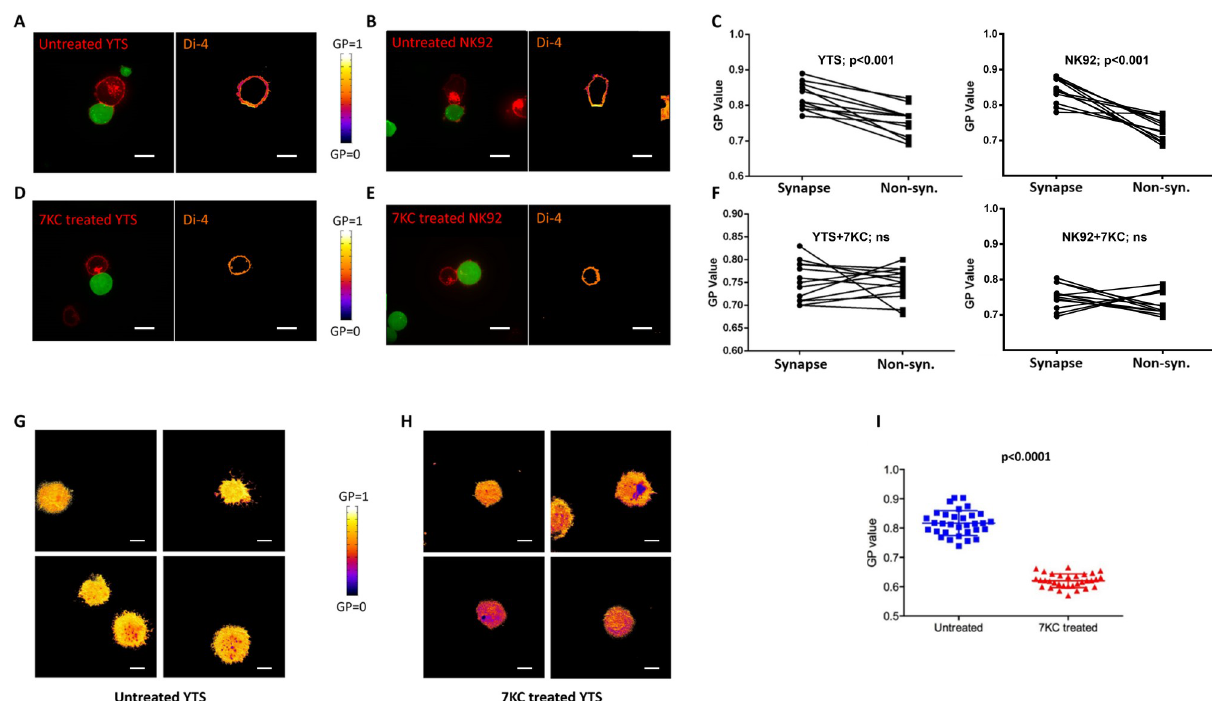
Fig 1. NK cells assemble presynaptic membranes with high lipid order during target cell engagement. The lipid packing of NK cell membranes in fluorescent packing sensor labeled YTS (A, D) and NK92 (B, E) conjugated with calcein green–loaded 721 or K562 target cells, respectively, was measured using live cell confocal microscopy (left image). 7KC-treated and untreated NK cells were overlaid with a pseudocolor scale (A, B, D, E–right image) to demonstrate differences in packing. Membrane lipid density was quantified as a GP value, which was measured in distinct conjugates ( n = 12 for untreated YTS, n = 14 for 7KC-treated YTS, n = 12 for untreated NK92, n = 12 for 7KC-treated NK92) performed over 4 independent experiments and the images shown were representative. The individual GP values for synaptic and nonsynaptic regions were compared as paired observations from individual cells in aggregate for YTS (C left, p < 0.001) and NK92 (C right, p < 0.001) cells using a paired t test and the difference was significant, but not when YTS (F left, p > 0.05, ns) and NK92 (F right, p > 0.05, ns) cells were treated with 7KC. The lipid packing of the NK cell presynaptic membrane was further measured using TIRF microscopy on activating glass surfaces (anti-CD18 with anti-CD28 for YTS), and 4 representative images from untreated (G) and 7KC-treated YTS cells (H) were overlaid with a pseudocolor scale to allow visualization of packing differences (G vs H). Packing density was quantified as a GP value in 32 distinct cells from 4 independent experiments, and an unpaired t test was used for the comparison of the means (I) and the difference was significant p < 0.0001. Scale bar: 10 μ m. GP, generalized polarization; NK, natural killer; ns, not significant; TIRF, total internal reflection fluorescence; 7KC,